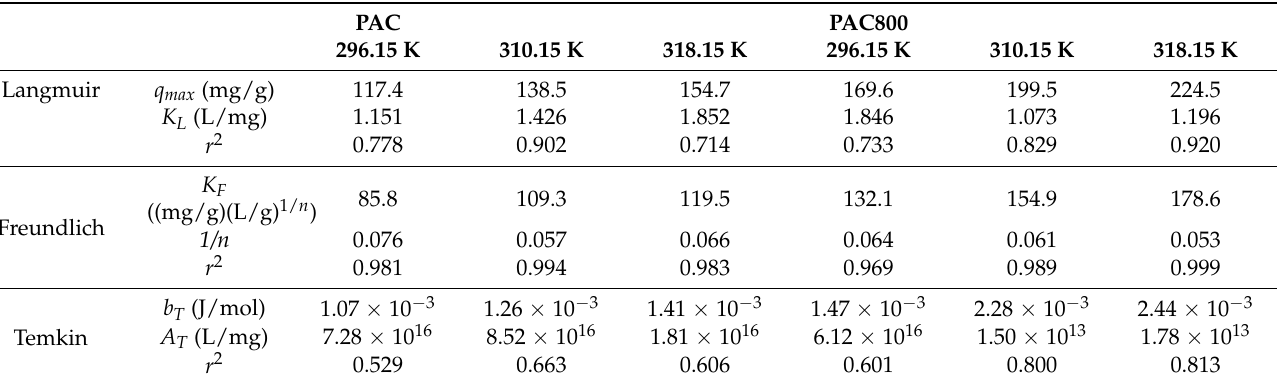
Table 4. Results of adsorption